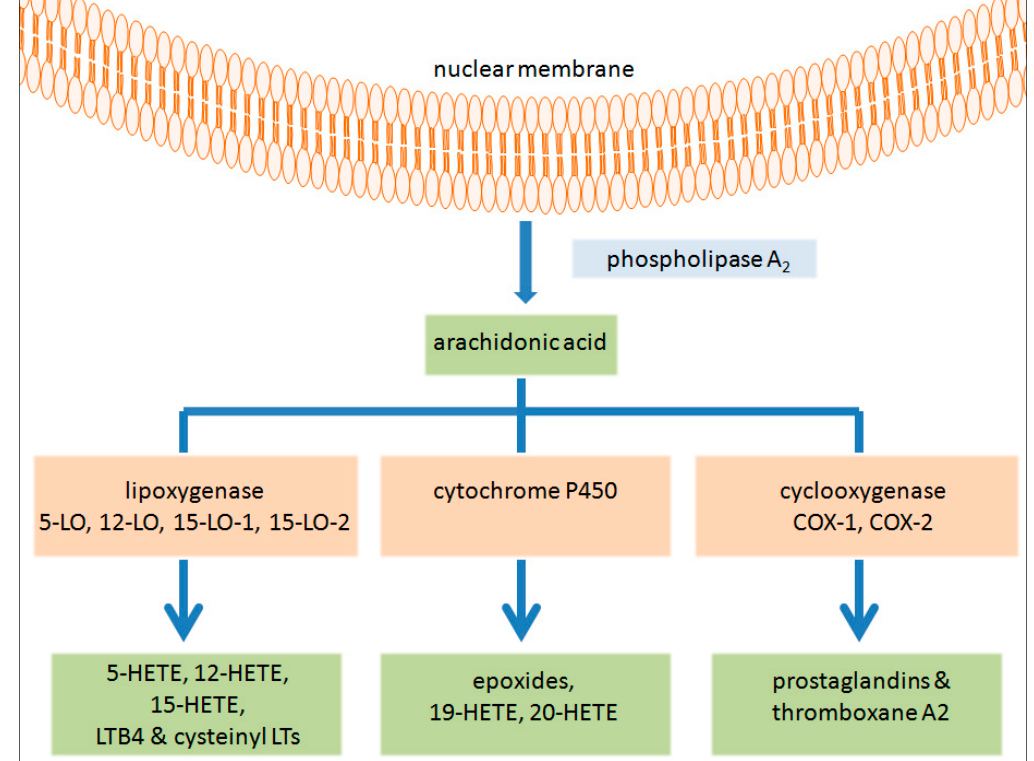
Figure 1. Arachidonic acid metabolism produces bioactive lipid signalling molecules known as eicosanoids: Upon cellular stimulation, phospholipase A2 induces the release of free fatty acids (FFAs), mostly arachidonic acid (AA), from the lipid bilayer of the nucleus. The released AA is metabolised by one of three different enzymatic pathways into the bioactive lipid signalling molecules, known as eicosanoids. 5-lipoxygenase (LO) metabolises AA to 5-HETE, LTB4 and the cysteinyl leukotrienes (LTC4, LTD4 and LTE4), 12-LO metabolises AA to 12-HETE. Both isoforms of 15-LO metabolise AA to 15-HETE and to a lesser extent 12-HETE. Cytochrome P450 metabolises AA to 19-/20-HETE but mostly epoxides. Cyclooxygenase (COX)-1 and 2 metabolises AA to thromboxane A2 or a series of prostaglandins (PGD2, PGE2, PGF2, PGH2 and PGI2).